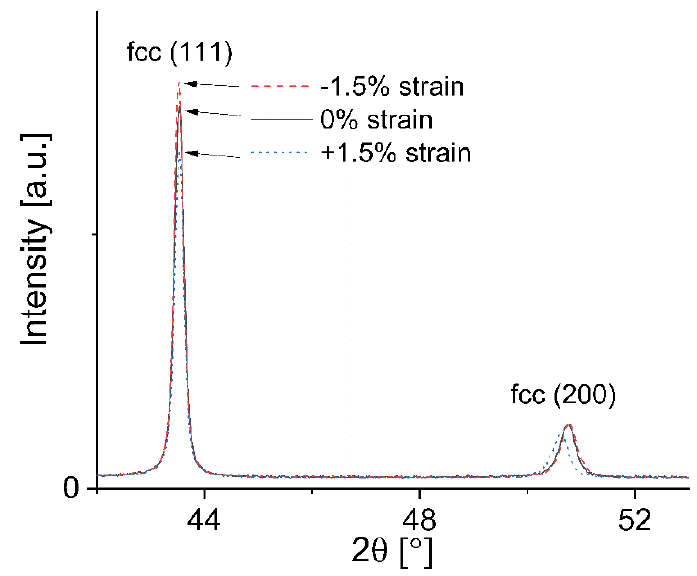
Figure 7. XRD measurements of 316L taken at 0% strain, + 1.5% and − 1.5% strain. The normal vector of the di ff raction planes is aligned parallel to the loading